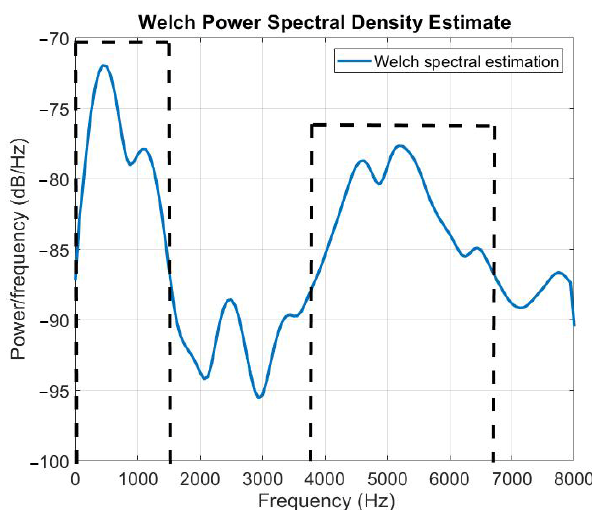
Figure 6. Welch spectral estimation for a frame of speech signal by selecting the proper spectral areas (black dash lines).